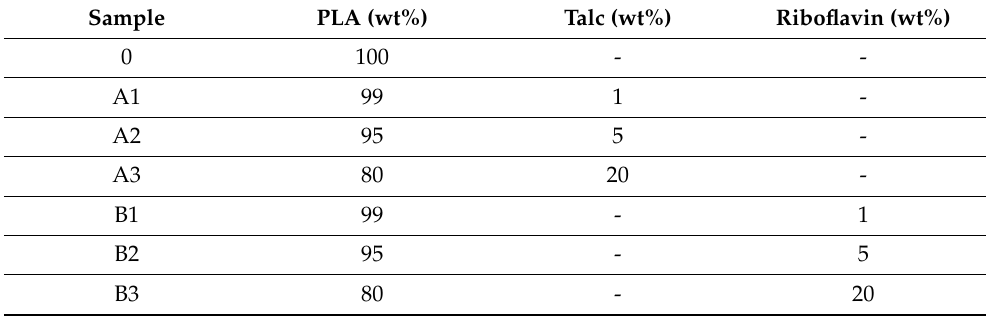
Table 2. Samples and raw materials used for the research. Abbreviations: 0—control (PLA without additives); A1–A3—samples with 1%, 5%, and 20% of talc, respectively; B1–B3—samples with 1%, 5%, and 20% riboflavin, respectively.